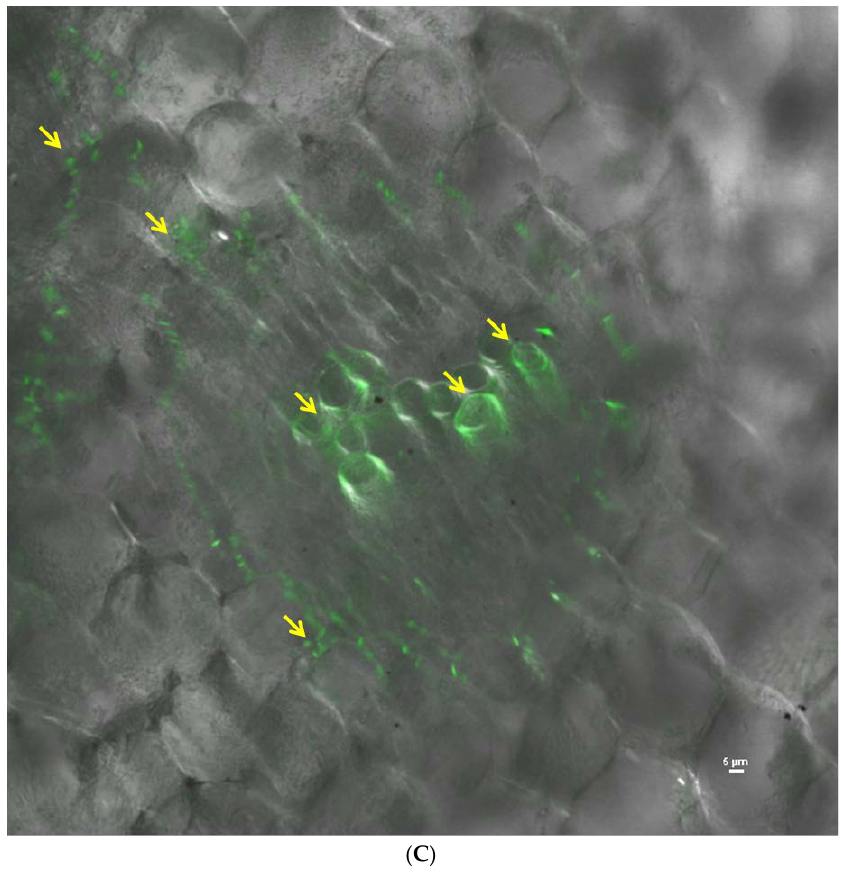
Figure 8. Confocal scanning laser microscope images showing colonization of gfp -tagged R. solanacearum NAIMCC-B-01630 in tomato root; red arrows indicate vascular colonization of the tagged pathogen in 488 channel, and yellow arrows indicate the same in the TD channel ( A ) vascular colonization as seen in the 488 nm channel, ( B ) vascular colonization as seen in TD channel, and ( C ) superimposed image of 488 and TD channels.